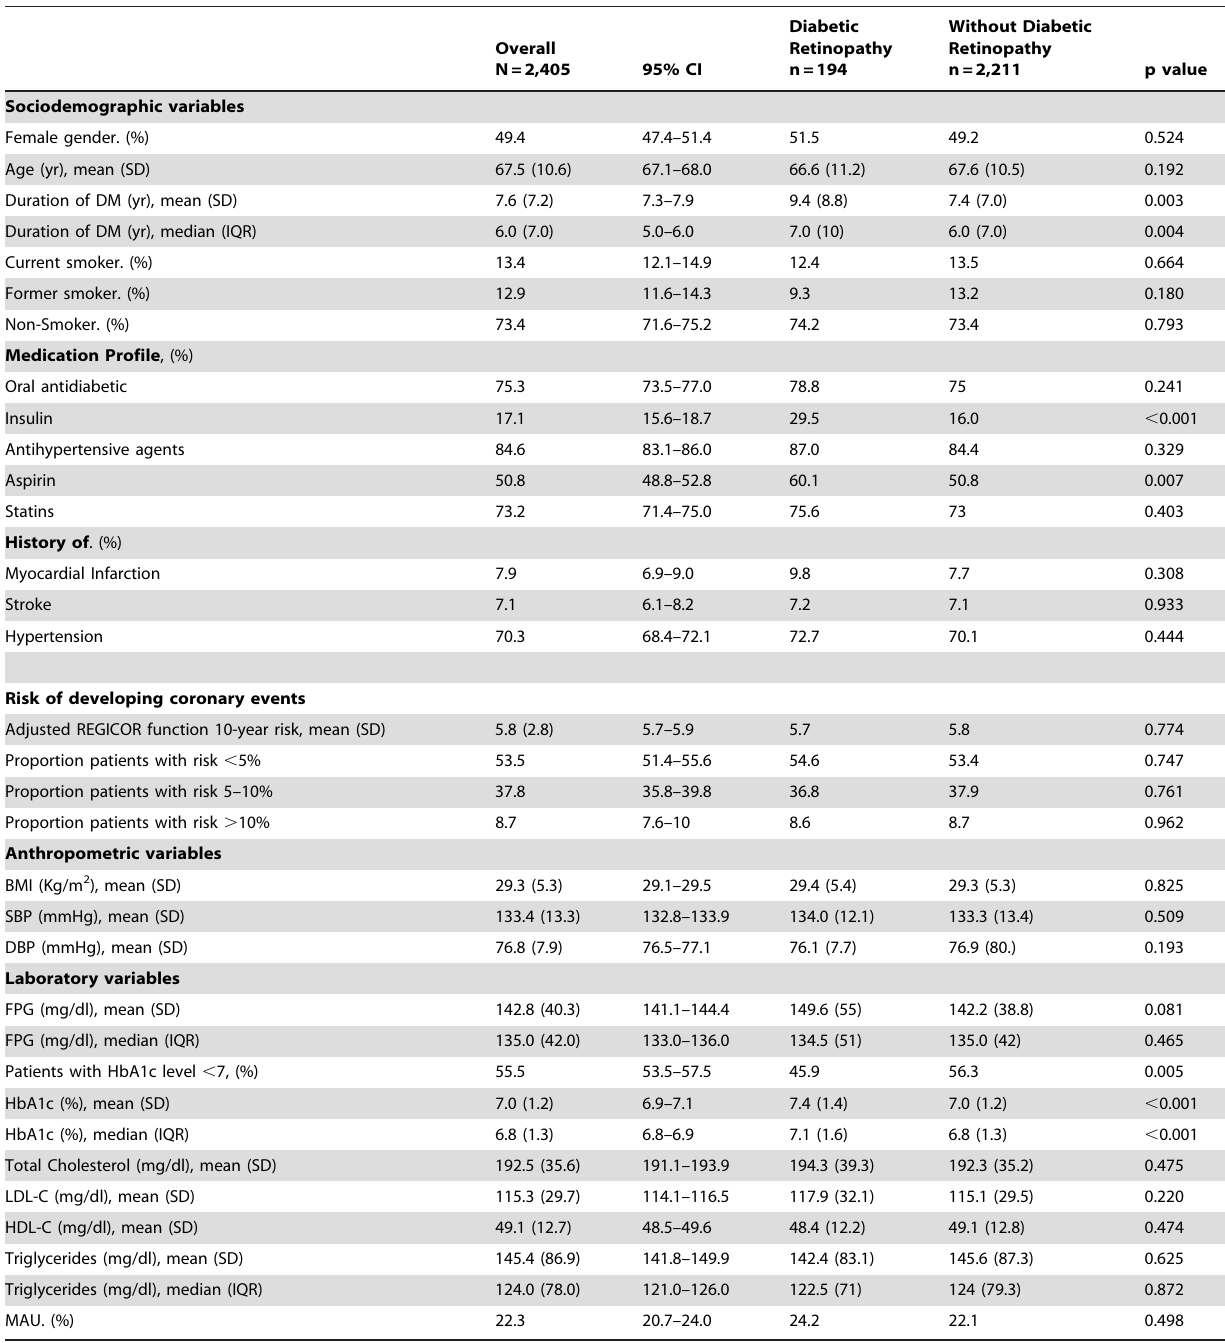
Table 2. Baseline characteristics of follow-up patients (n=2,405).